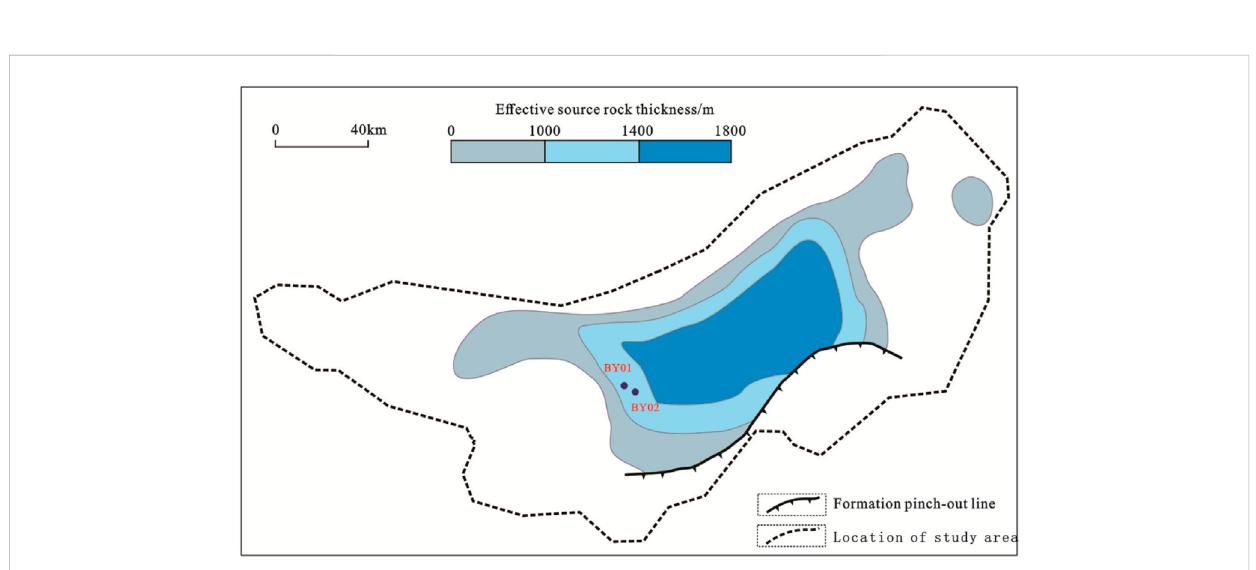
FIGURE 10 Isothickness map of Palaeogene effective source rocks in Baiyun Sag Mi et al.,